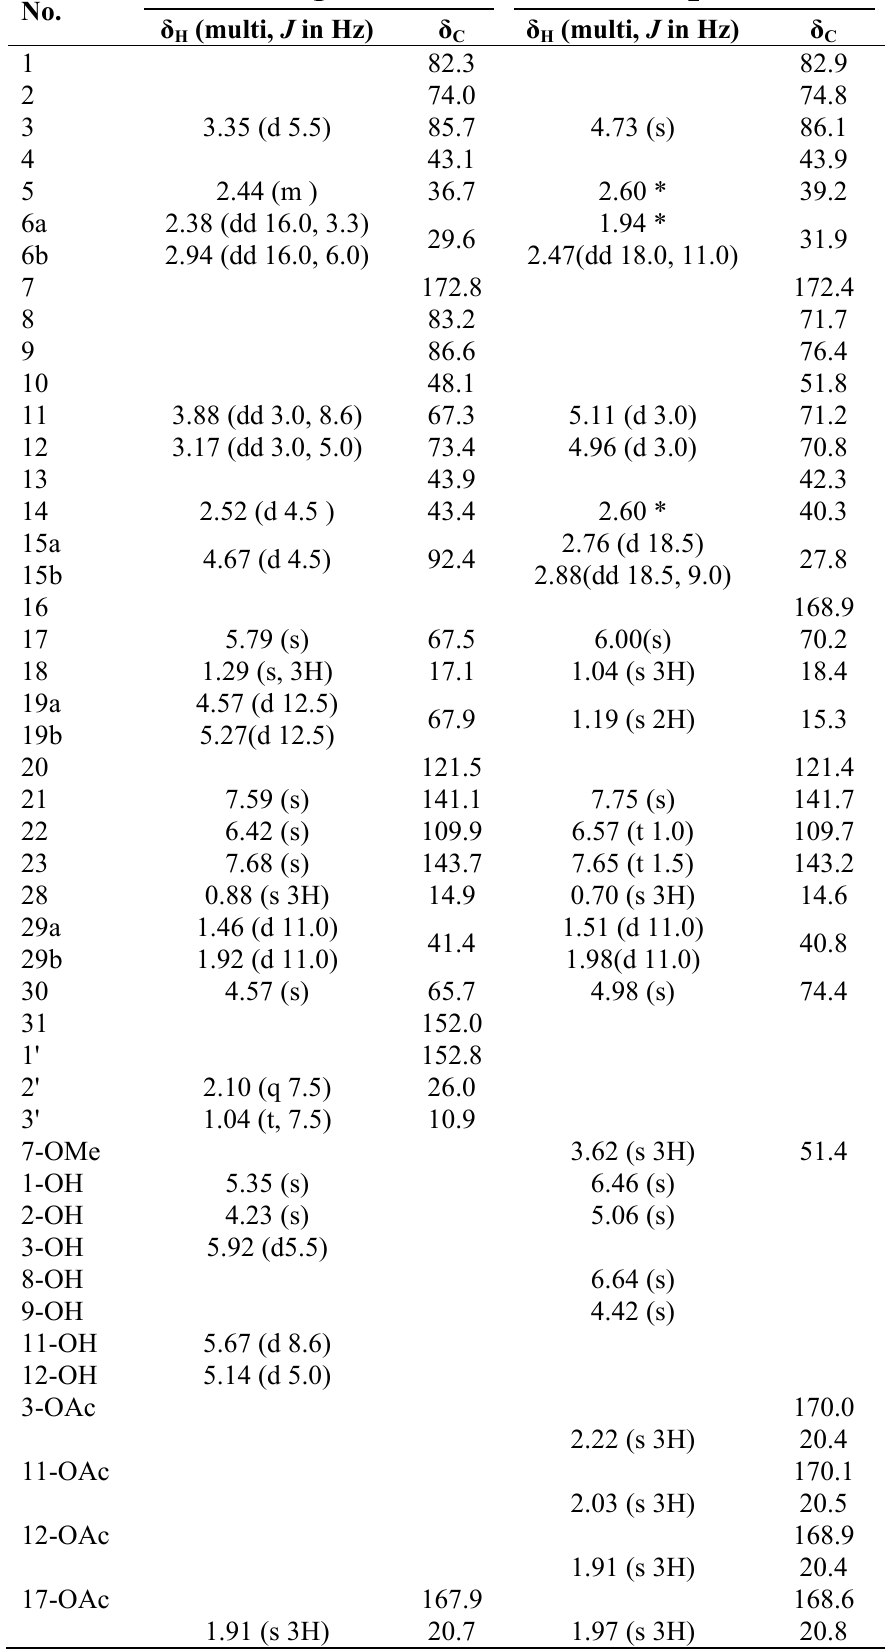
Table 1. 1 H (500 MHz) and 13 C (125 MHz) NMR data of 1 and 2 in DMSO- d